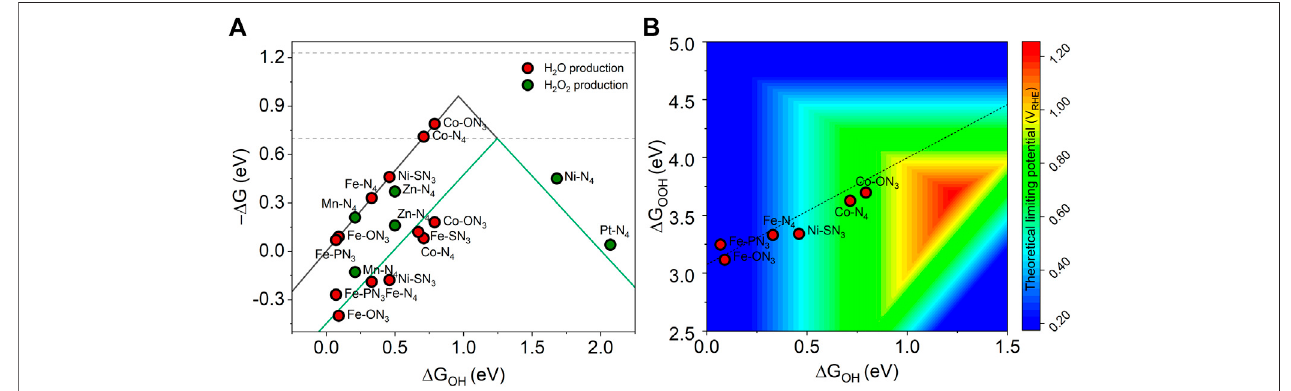
FIGURE4| (A) Catalytic activity toward theH 2 Oproduction (black solid line) and H 2 O 2 production (green solidline), (B) A2-Dvolcanomap with Δ G OOH and Δ G OH as descriptors for the theoretical limiting potential of ORR on M-YX 3 with a positive limiting potential.